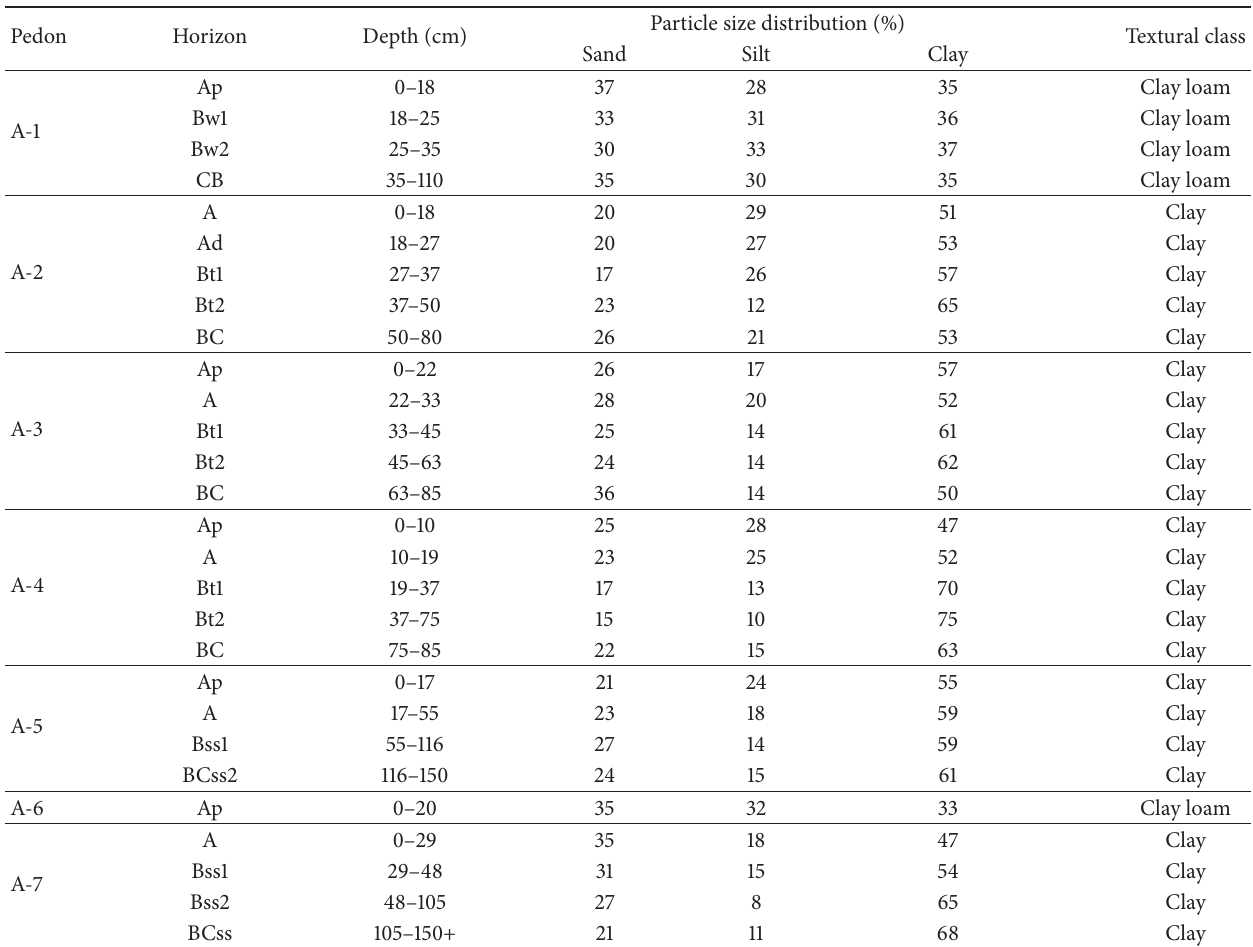
Table 3: Particle size distribution and textural classes of soils of Abobo